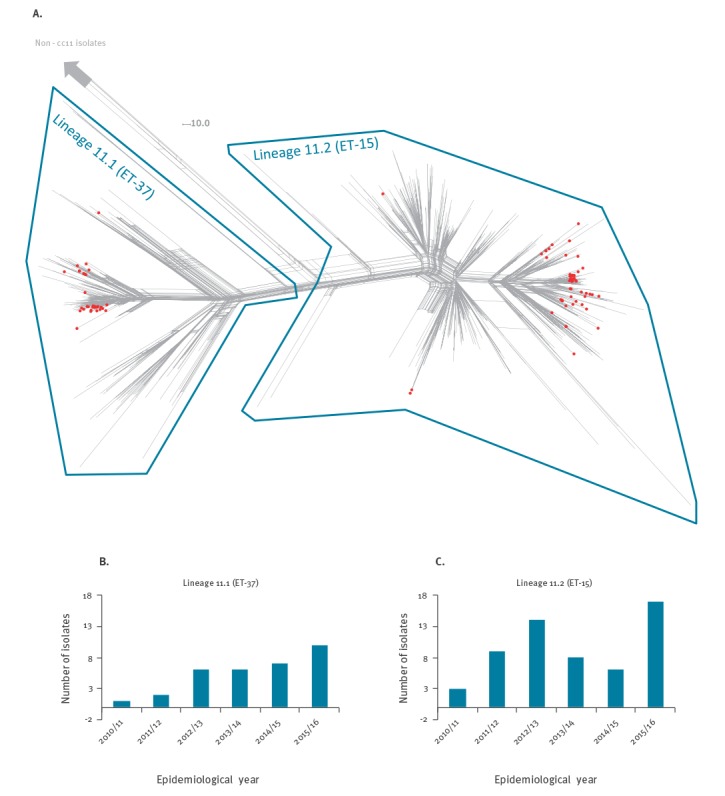
Diversity and temporal distribution of meningococcal serogroup C case isolates, England, 2010/11–2015/16